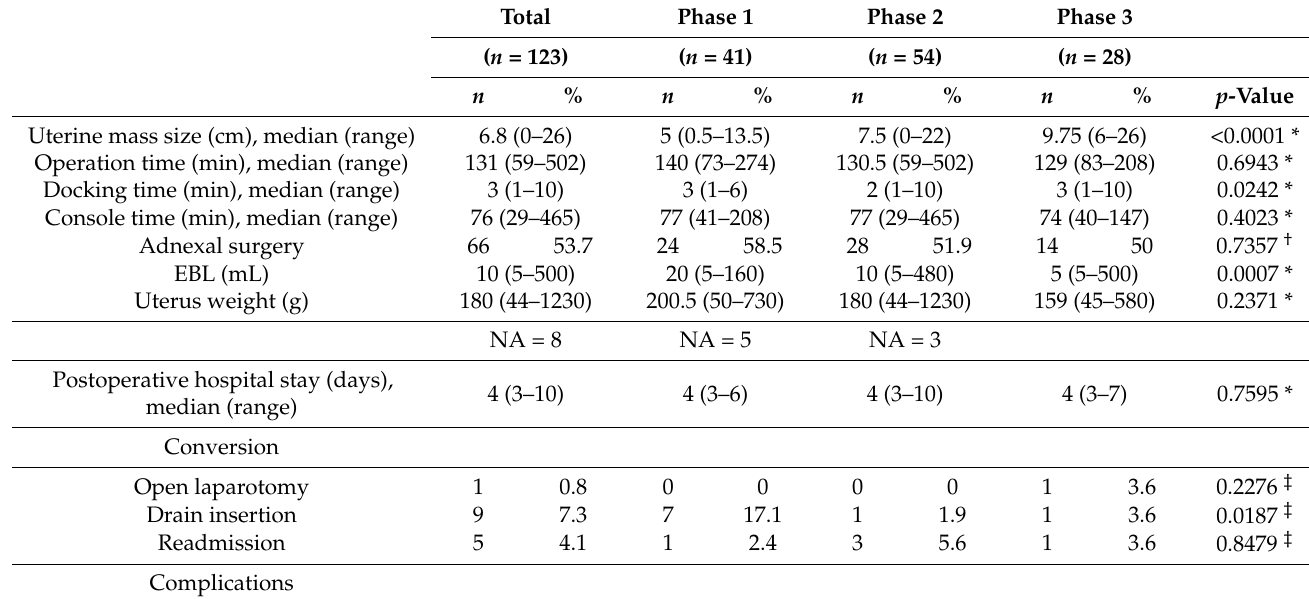
Table 2. Surgical outcomes of single-port robotic